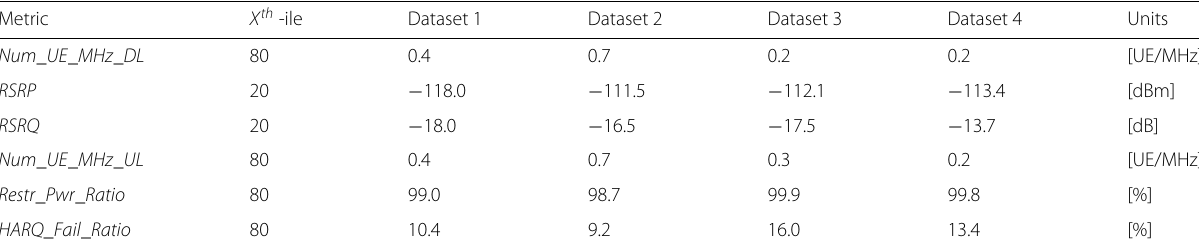
Table 4 Defined thresholds based on the X th percentile of the metrics for each dataset Metric X th -ile Dataset